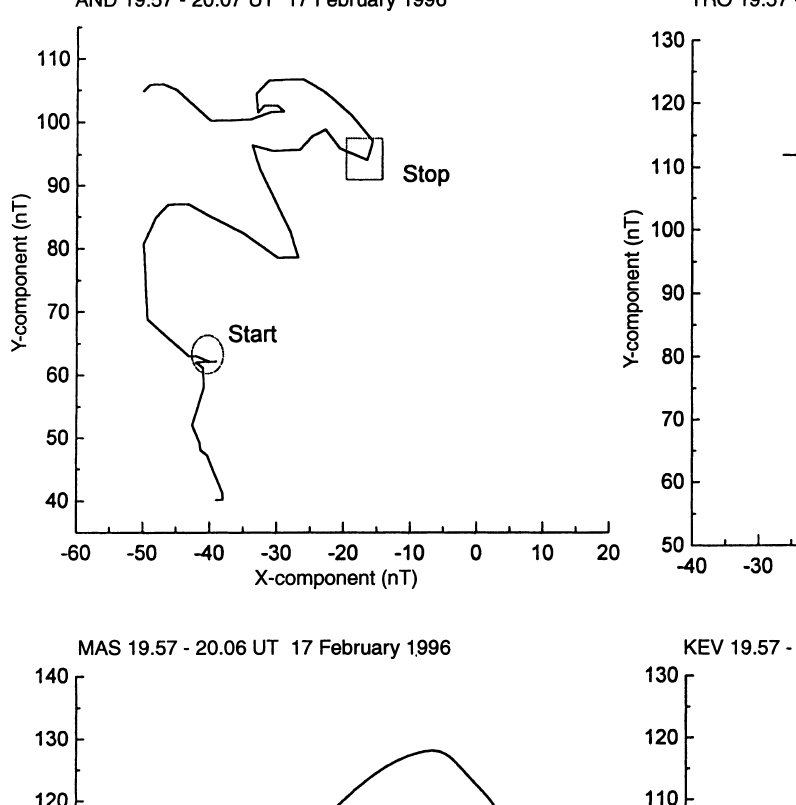
KEV and b along the longitude from BJN to OUJ (see Fig. 4a, b). The Tromsø heater turning on and o(cid:128) are marked by circles and